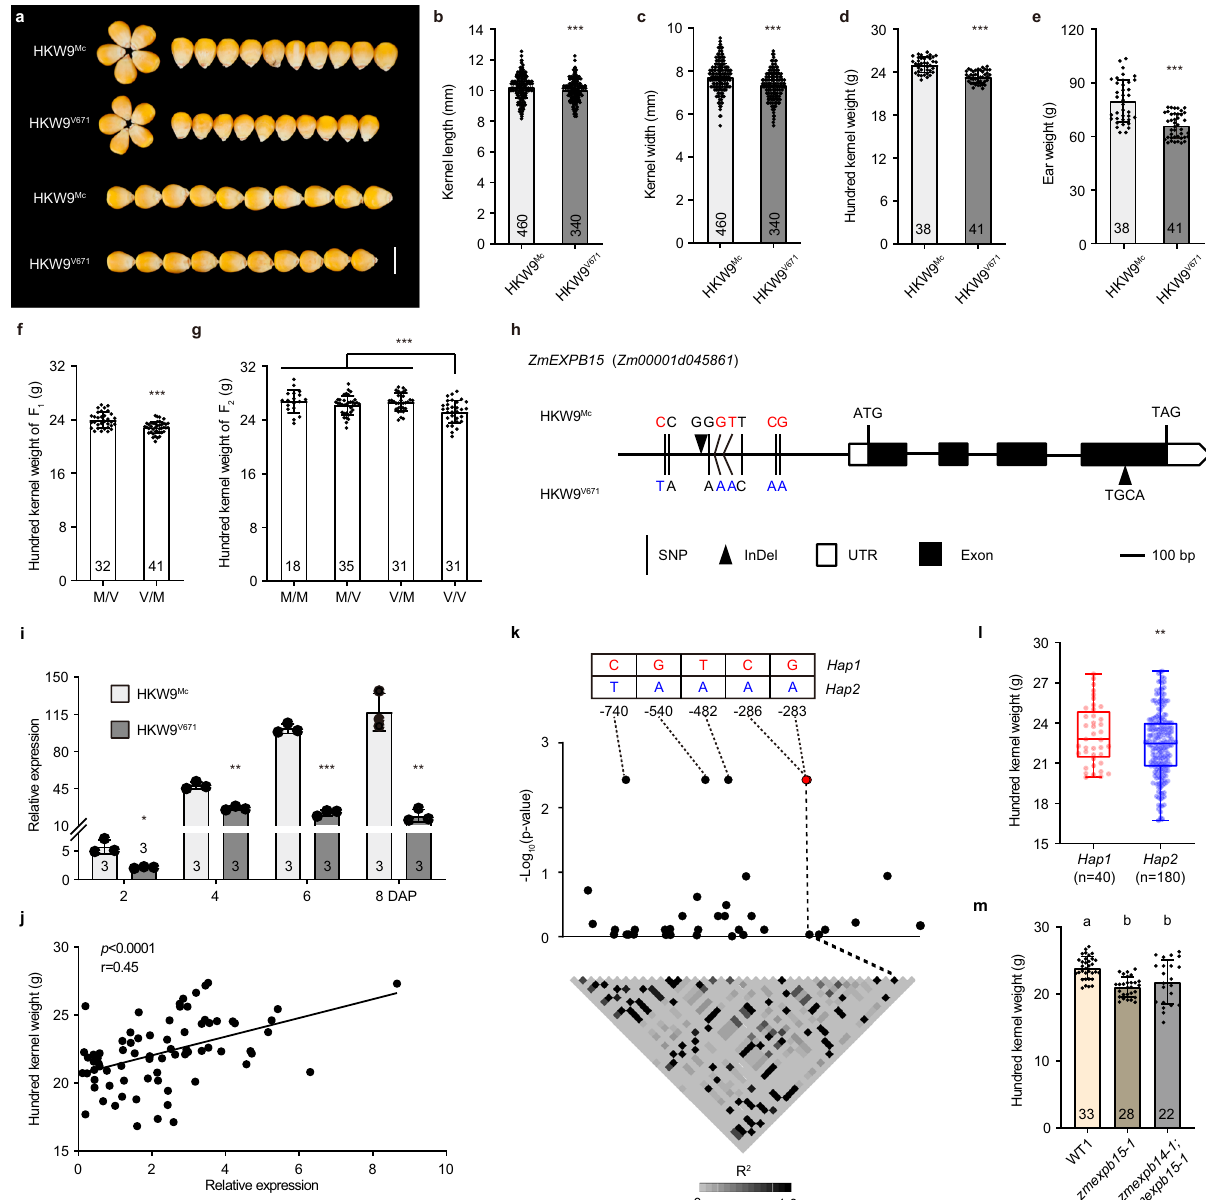
Fig.1| HKW9 actsmaternallytocontrolkernelsizeandweight.a Comparisonof mature kernels between HKW9 Mc and HKW9 V671 . Scale bar=1cm. b – e Quantitative analysis of kernel length ( b ), kernel width ( c ), hundred kernel weight ( d ) and ear weight ( e ) between HKW9 Mc and HKW9 V671 . f , g Quantitative analysis of hundred kernel weight (HKW) of F 1 kernels ( f ) from the HKW9 Mc /HKW9 V671 (M/V) and HKW9 V671 /HKW9 Mc (V/M) plants, and F 2 kernels ( g ) from the HKW9 Mc /HKW9 Mc (M/ M),M/V,V/MandHKW9 V671 /HKW9 V671 (V/V)plants. h Genestructureofthecandidate gene, Zm00001d045861 ( ZmEXPB15 ),andthepolymorphismsbetweenHKW9 Mc and HKW9 V671 . Eight SNPs (black lines) and one 1-bp InDel (black triangle) in the pro- moter and one 4-bp InDel (black triangle) in the last exon are shown; white boxes, untranslated regions; black boxes, coding sequences. i Expression of ZmEXPB15 is higher in large kernel NIL HKW9 Mc in early developing kernels. All expression levels from three biological repeats were normalized to Actin . j Pearson correlation between ZmEXPB15 expression and the HKW among 75 inbred lines. k The